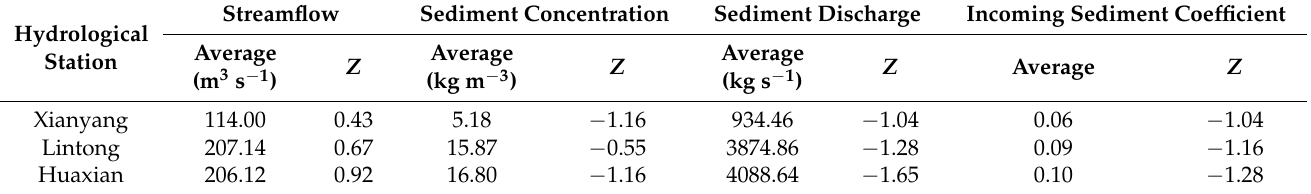
Table 3. Average streamflow-sediment indexes data of hydrological stations in the lower Weihe River during flood season in 2006–2018.